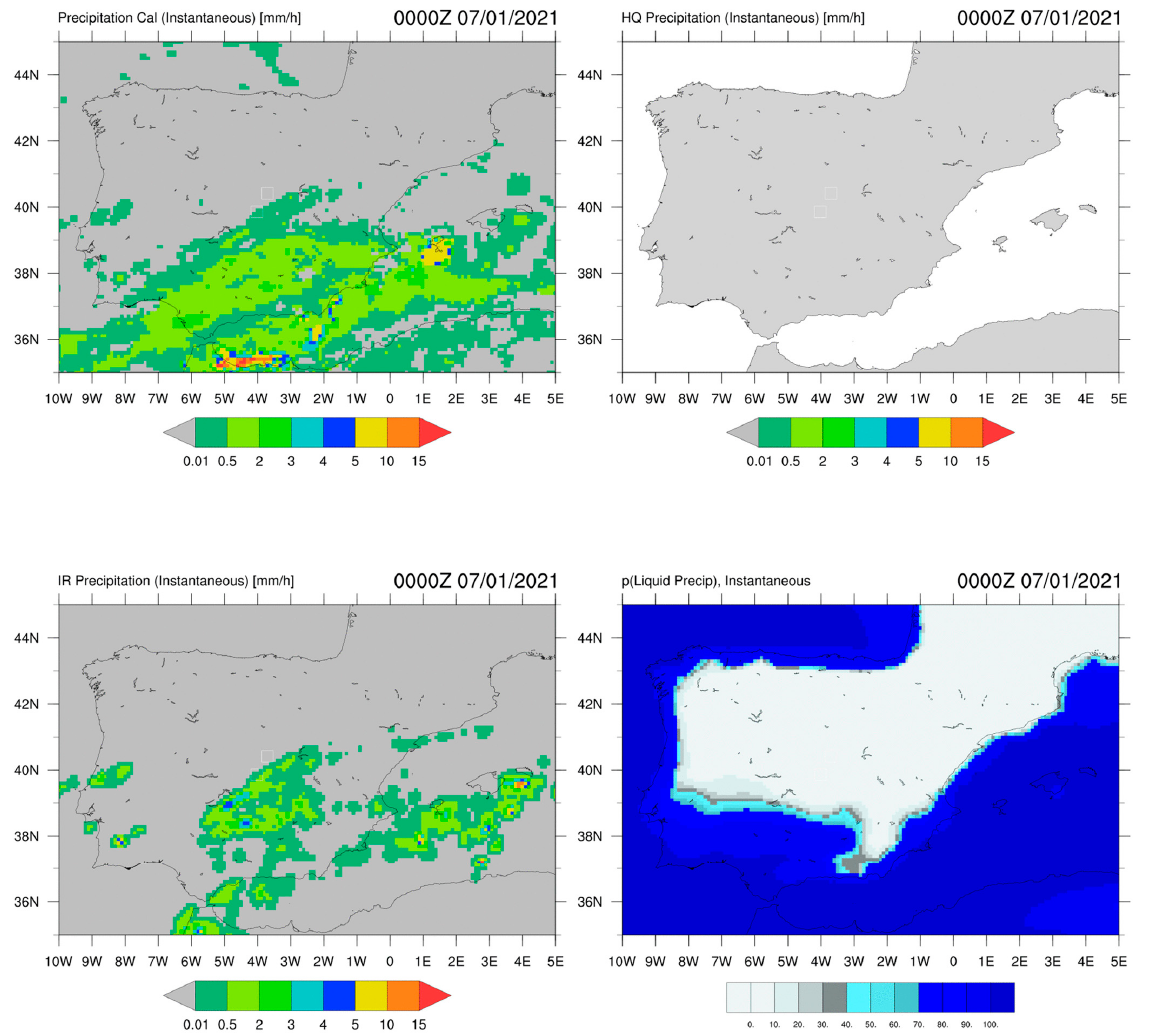
Figure 5. The evolution of the precipitation over Spain every 30 min for January 7th to 9th, as described by three fields of the IMERG-L algorithm (Calibrated, HQ and IR), plus the estimated probability of liquid precipitation (included in the IMERG-L files). The spatial resolution of the estimates is 0.1° (about 10 km at the latitude of Madrid). The top square in the middle corresponds to the Madrid area (Figure 3), the lower is the Toledo area (Figure 4). Raw data were obtained from the Precipitation Processing System (PPS); processing and graphics were done at UCLM using Fortran programs and NCL scripts. [The sequence of events can be found in animated format. If reading a static version of this text, please see the animated figure in the supplementary information].